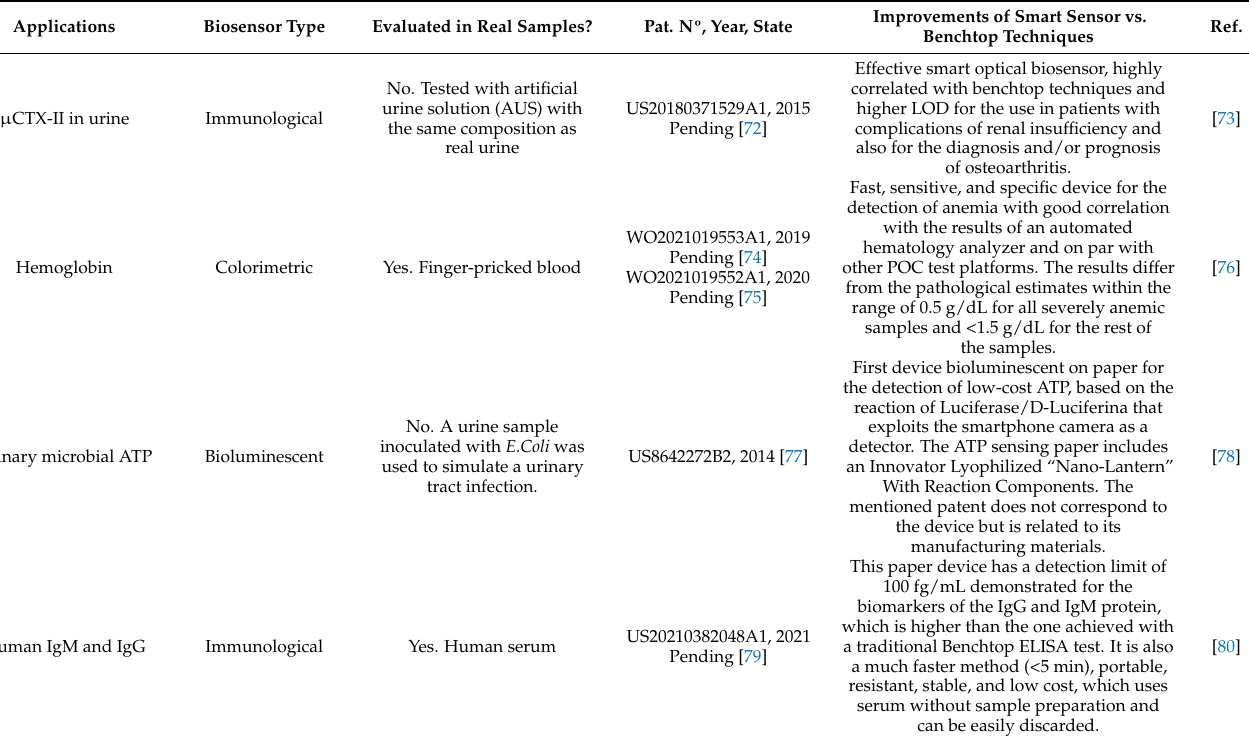
Table 3. Smart paper-based biosensor devices classified according to the principle and the type of